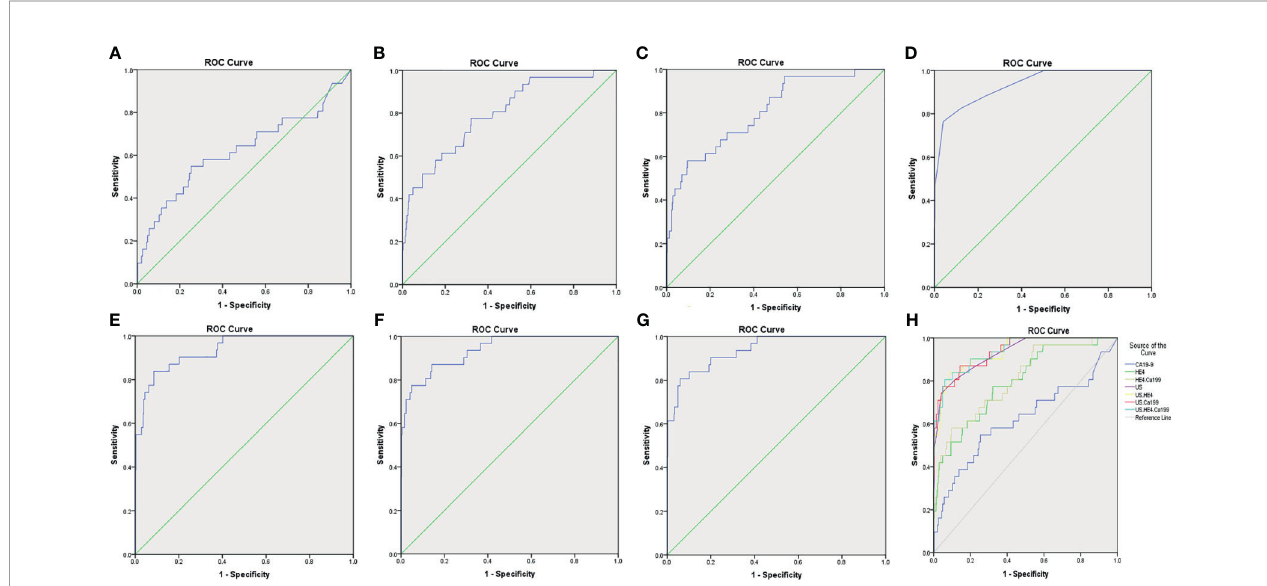
mean ± SD, mean ± standard deviation. *Represents statistical difference between display rates (p <